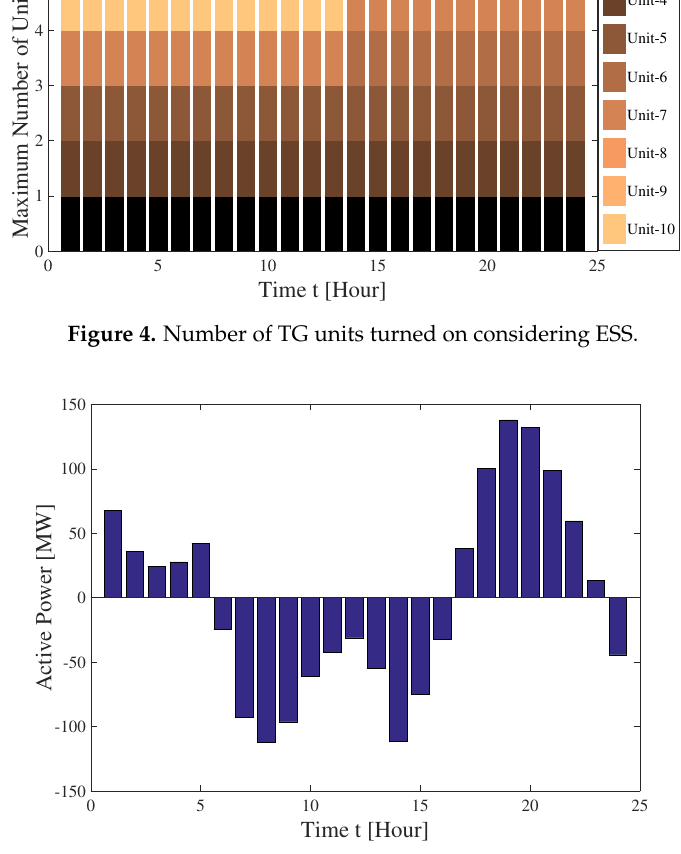
Figure 5. Optimal charging and discharging dynamics of ESS.